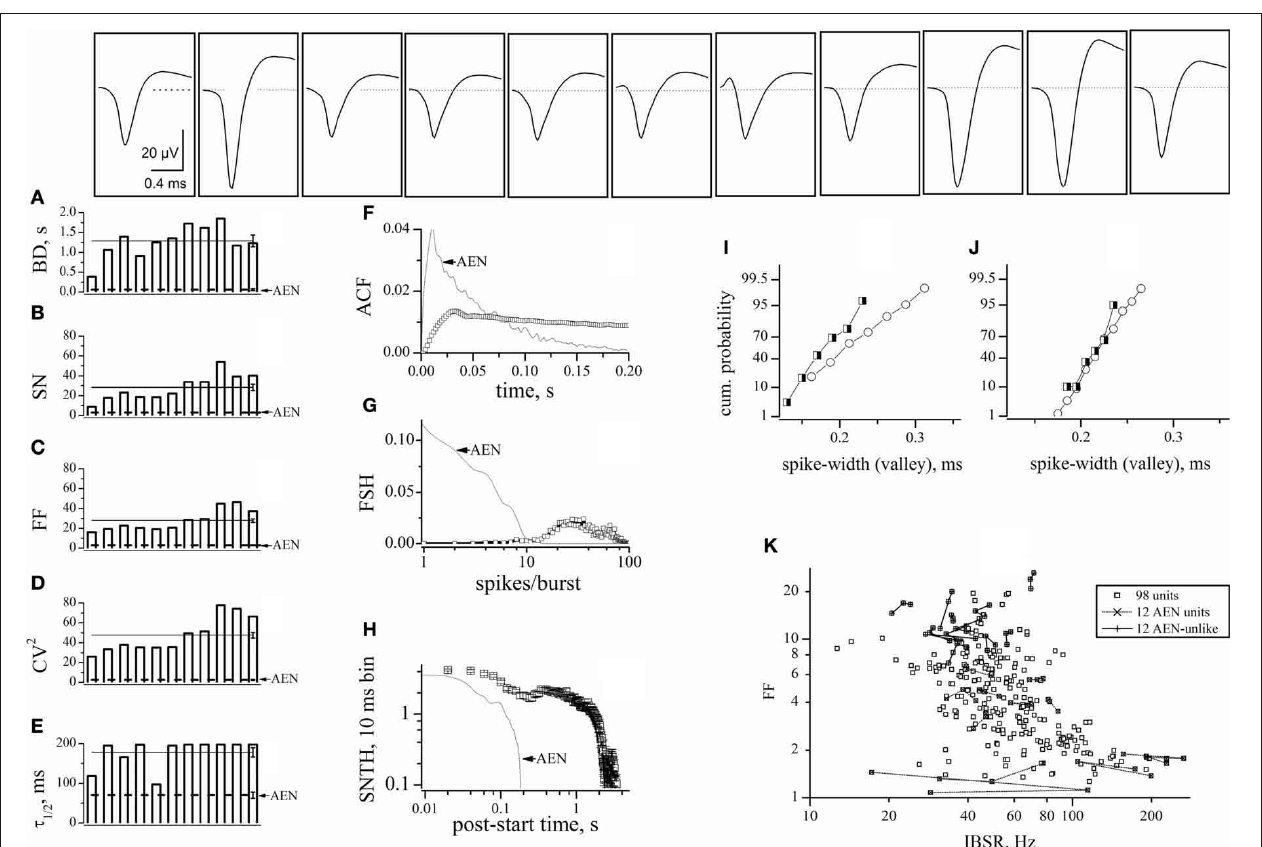
FIGURE 5 | Characterization of AIN-like units. Properties of units identified from electrodes sampling from a region containing at least one GFP + cell, but yielding no AEN-like spikes. The upper insets show typical waveforms of the spikes assigned to each unit. (A–E) plots of BD, SN, FF, CV 2 , and τ 1 / 2 , respectively. These were computed from 2h continuous recordings comprising approximately 160 bursts, for each of the 11 units whose spike templates are shown in the upper insets. In the same plot, the straight continuous lines (with error bars on the right end) represent the corresponding average values for these AINs. For comparison, the dotted lines represent the corresponding values for AEN units, reproduced from Figure 3 . (F) The ACF of the 11 units mean (open squares). (G) The FSH of the 11 units mean (open squares). (H) The SNTH of the 11 units mean (open